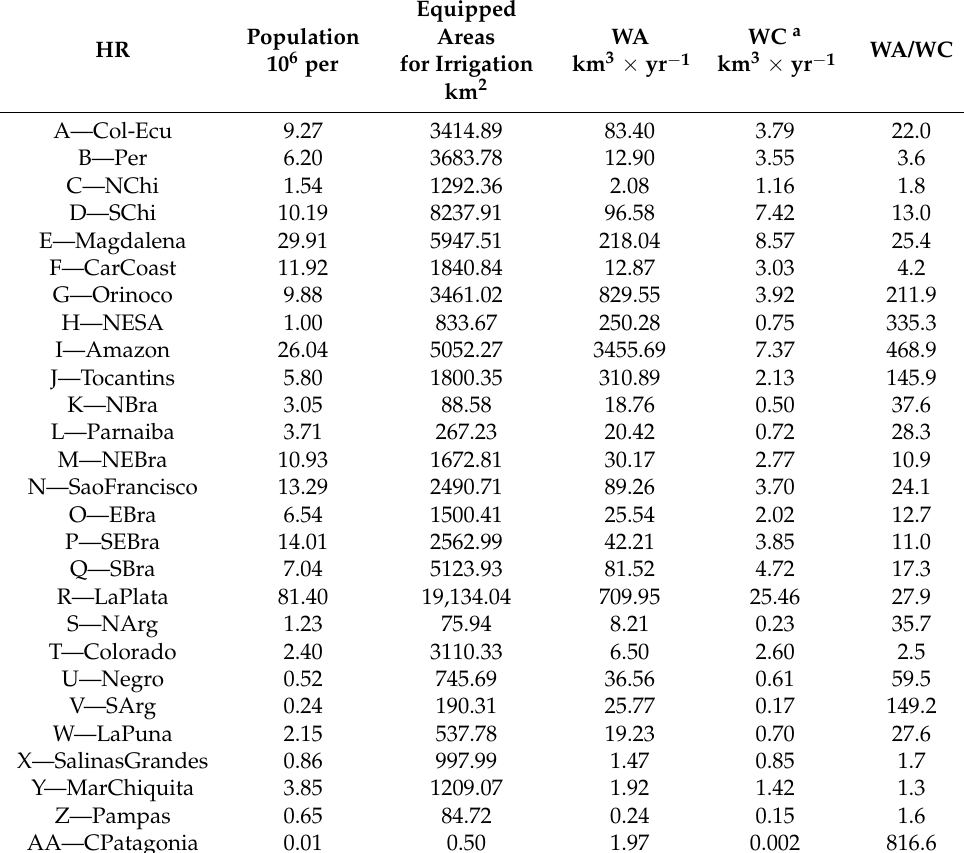
Table 4. Estimates of water consumption in the hydrological regions of South